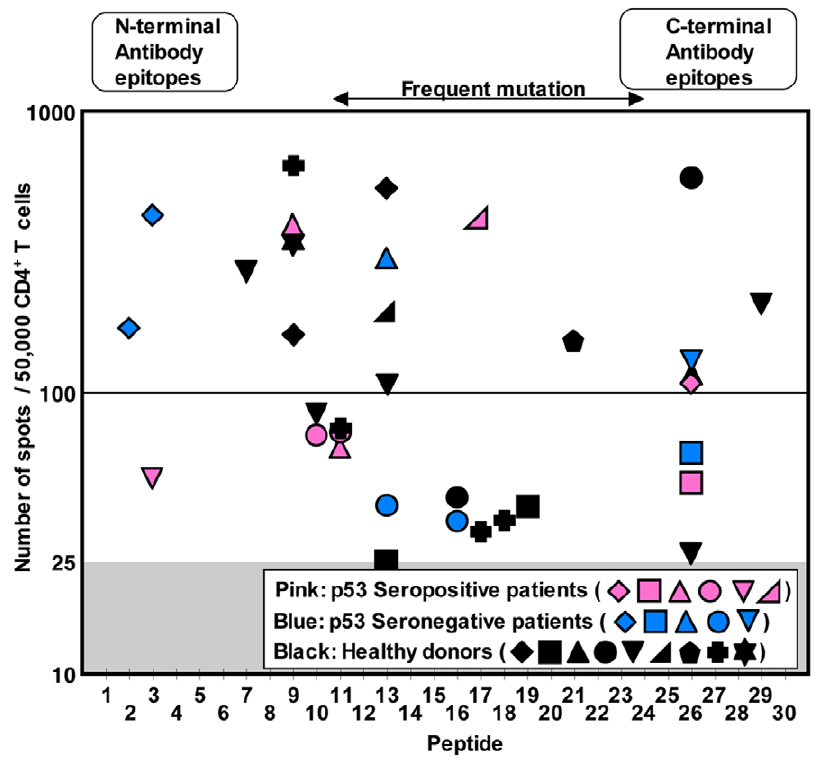
Figure 4. Distribution of CD4 + T cell epitopes in ovarian cancer patients and healthy donors. The magnitude of CD4 + T cell responses in ovarian cancer patients with or without p53-specific serum antibody and healthy donors against p53 overlapping peptides is plotted. Each symbol represents one individual. All responses shown were significant as compared to the number of background spots. 6/12 seropositive (pink symbols) and 5/10 seronegative (blue symbols) ovarian cancer patients and 9/12 healthy individuals (black symbols) showed positive CD4 + T cell responses against p53 peptide-pulsed target cells compared with unpulsed target cells.